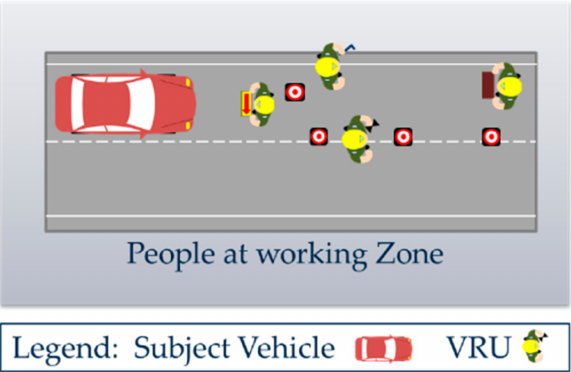
Figure 4. Roadway workers are standing by or moving around structures in a work